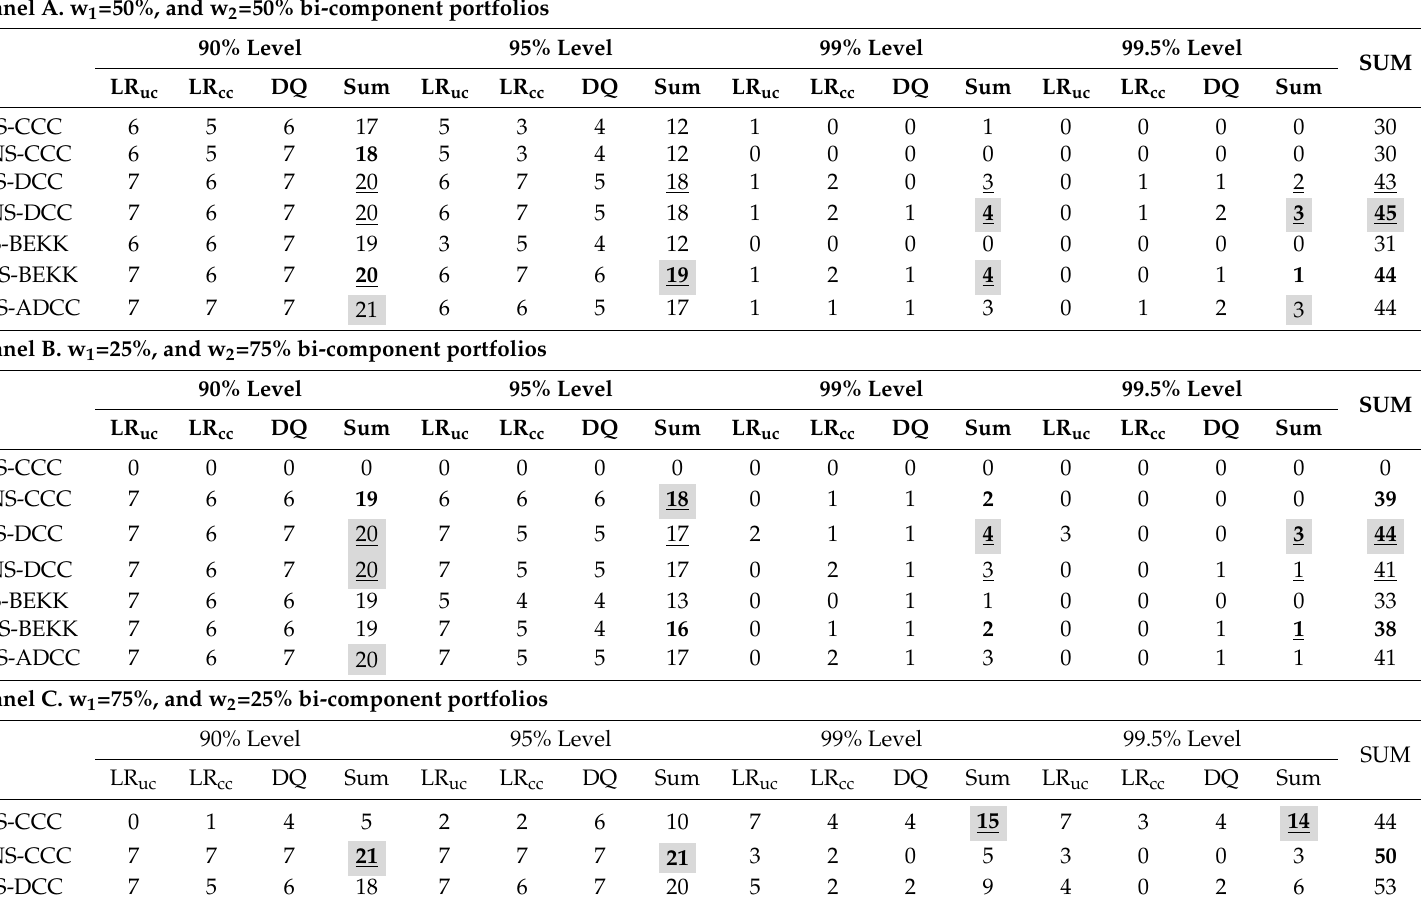
Table 10. All the summary results of the out-of-sample VaR forecast performance for the three weight combinations of currency-stock-based portfolios. Panel A. w 1 =50%, and w 2 =50% bi-component portfolios